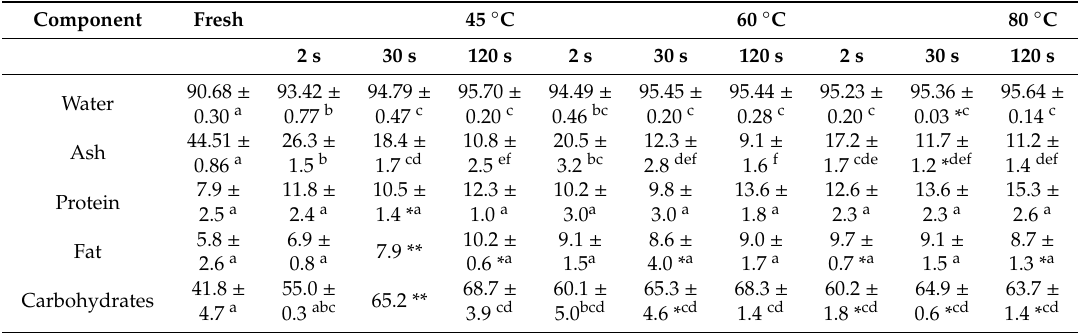
Table 2. Proximate composition of fresh and water-blanched Saccharina latissima. Data are expressed as means ± SD and represent three process replications ( n = 3). Water is given in % ww, whereas ash, protein (total amino acids), fat, and calculated carbohydrates are given in % dw. Component